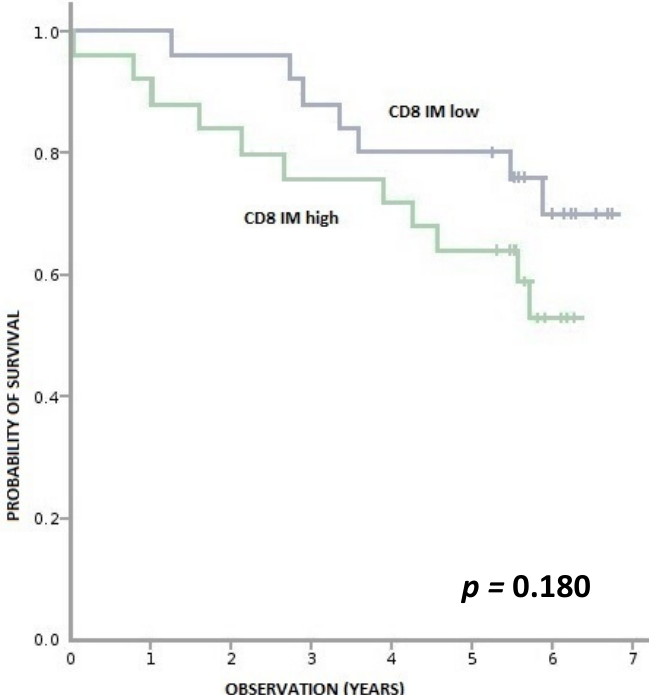
Figure A2. Overall survival according to density of CD8+ lymphocytes in IM (invasive margin). CD8+ IM high— ≥ 670 per 0.56 mm 2, CD8+ IM low—<670 per 0.56 mm 2 .